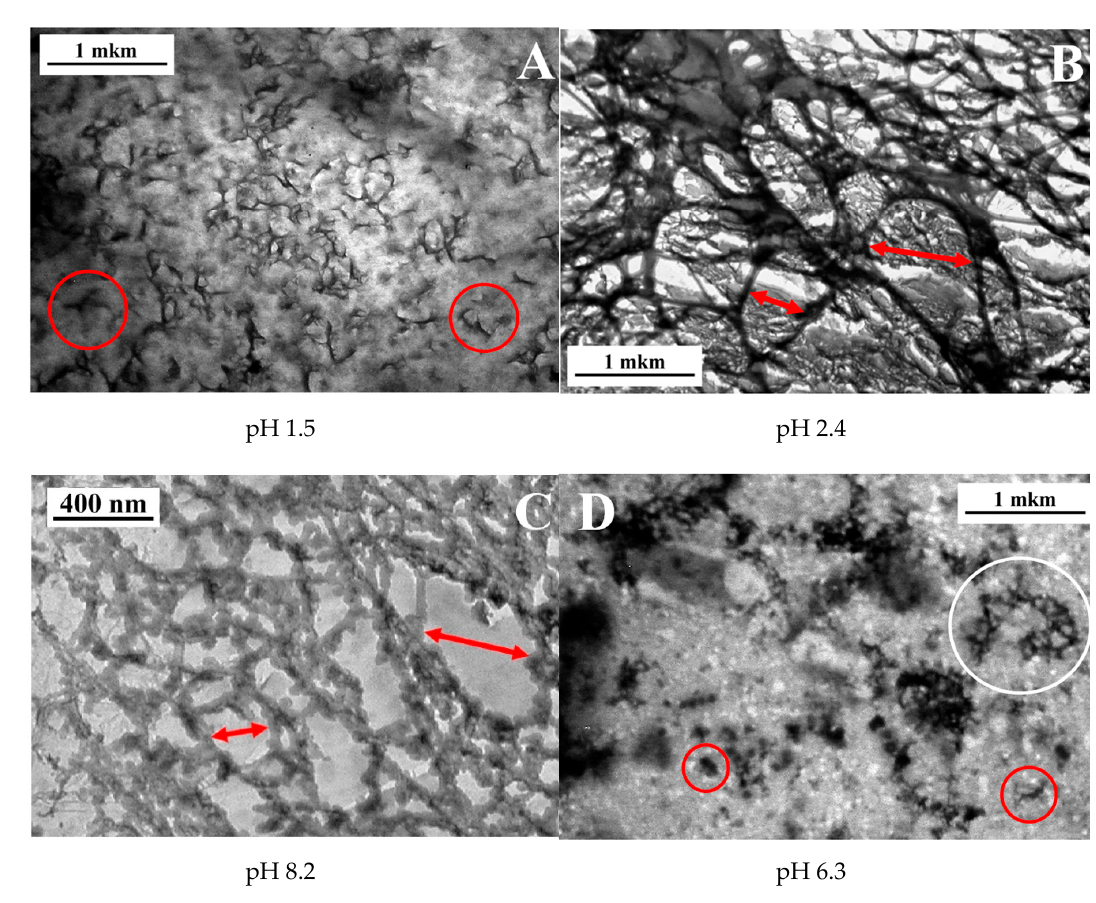
Figure 5. FF-TEM micrographs for 0.1 wt % xanthan aqueous solutions in the presence of 0.017 wt % CrCl 3 (molar ratio [CrCl 3 ]/[xanthan monomer units] = 1) prepared at different pH: 1.5 ( A ), 2.4 ( B ), 6.3 ( C ) and 8.2 ( D ) at 20 °C.